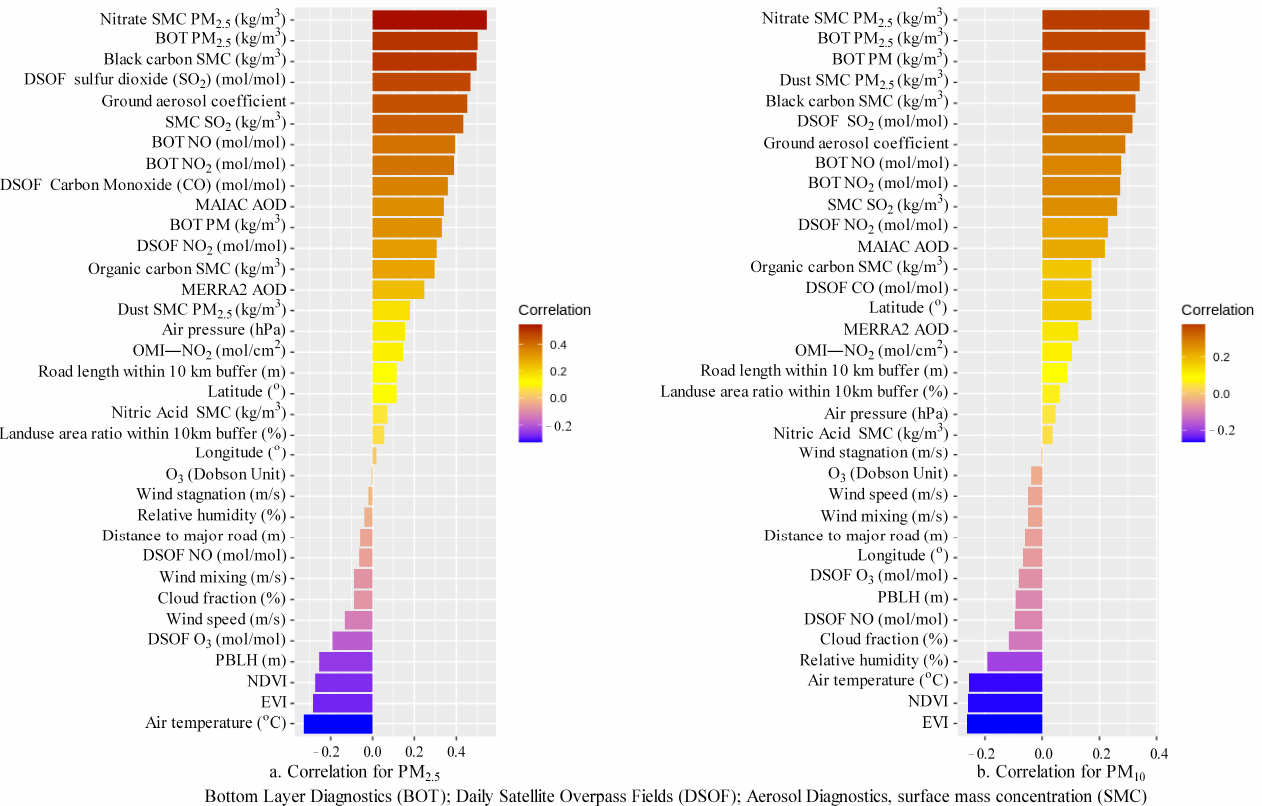
Figure 4. Bar plots of Pearson’s correlation for selection of the covariates (( a ) for PM 2.5 and ( b ) for PM 10